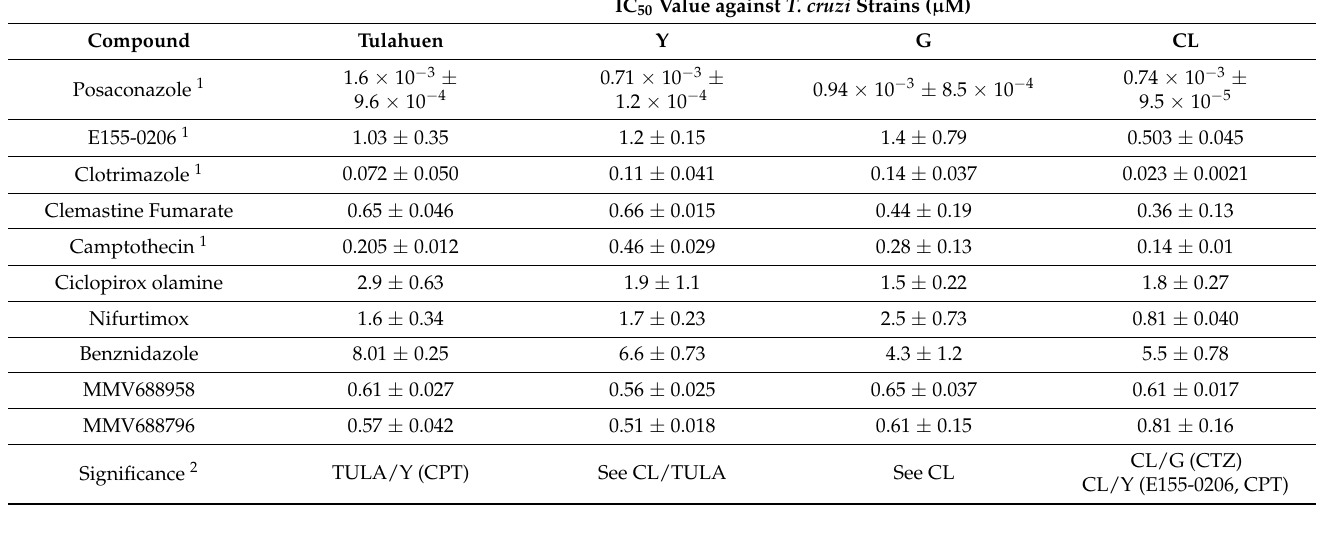
Table 1. IC 50 values of compounds with known activity against T. cruzi following 48 h incubation, against differing parasite strains: the cytochrome P450 inhibitors posaconazole, E155-0206 and clotri- mazole; the cell cycle inhibitor camptothecin; clemastine fumarate and compounds from the MMV Pathogen Box collection (unknown MOA against T. cruzi ) and drugs used to treat Chagas disease (nifurtimox and benznidazole). 1 Indicates compounds that did not clear 100% of parasites from host cells, across all parasite strains, with ≤ 95% maximum achievable activity (E max ). 2 Significance = a significant difference in the IC 50 value of compounds between strains ( p < 0.05), shown where the IC 50 for the strain is two-fold less than another. IC 50 Value against T. cruzi Strains ( µ M)